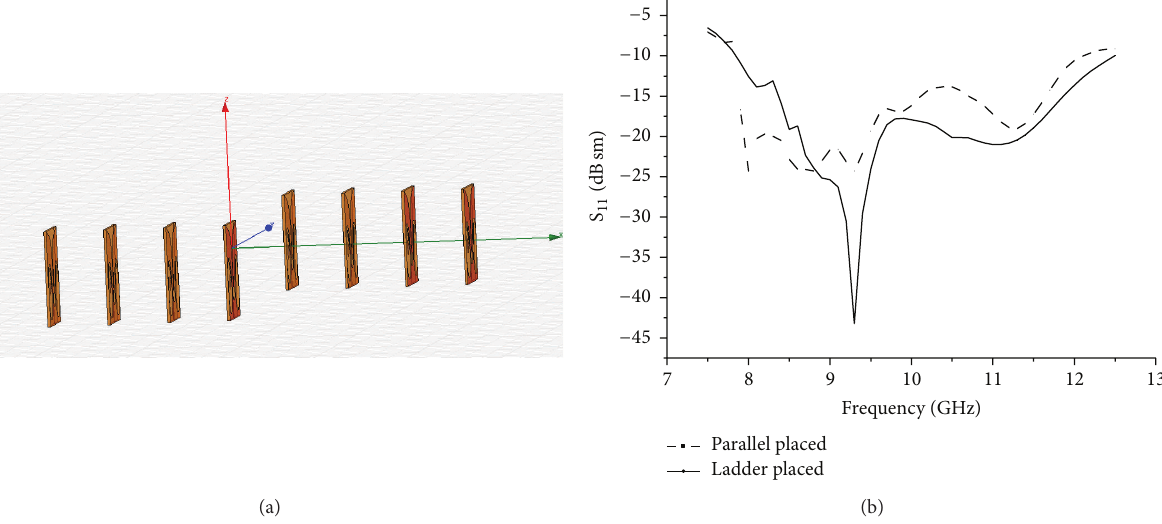
Figure 6: (a) Ladder arrangement of eight-element. (b) Active S 55 of eight-element array arrangement.